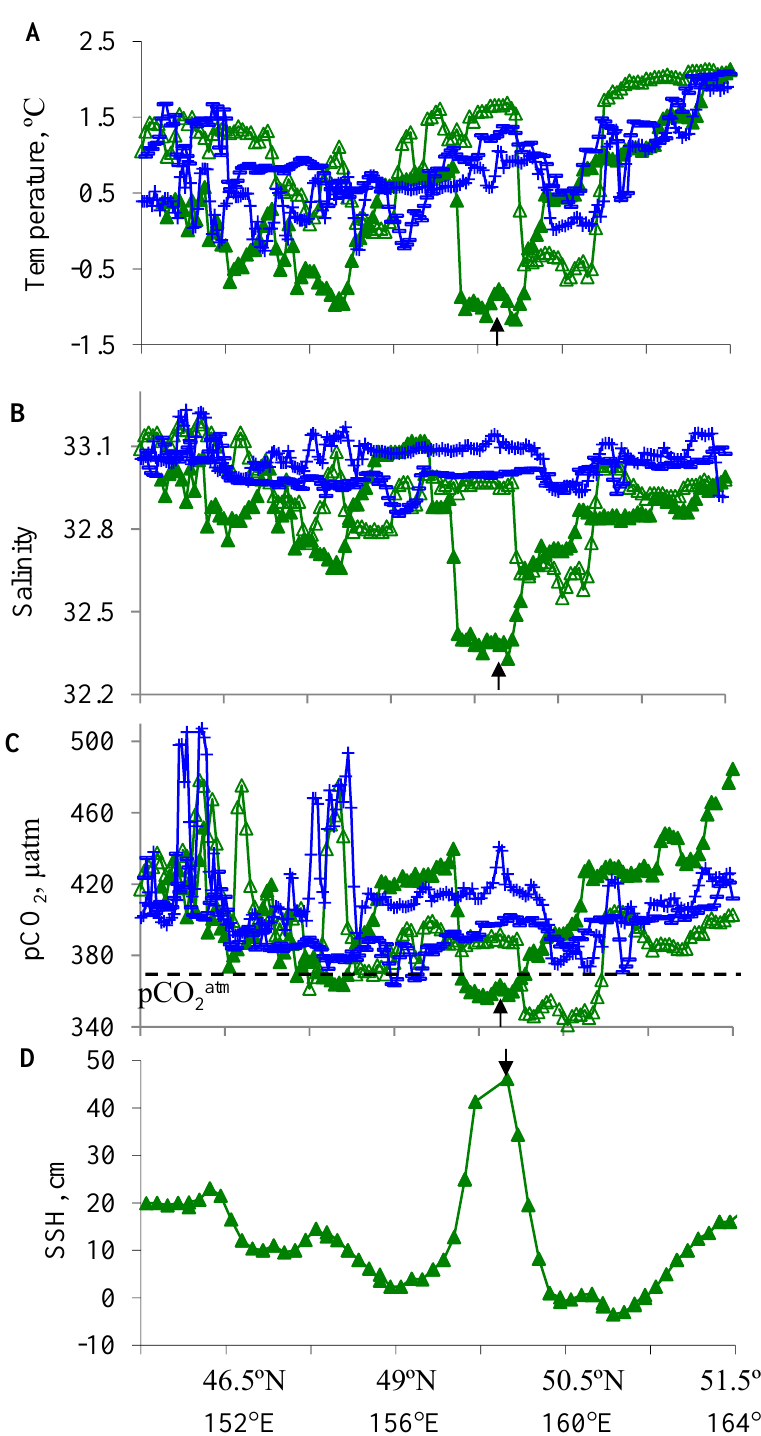
Figure 6. The distributions of the temperature ( A ), salinity ( B ), pCO 2 ( C ), and SSH ( D ) in the EKC zone in winter 1999 and winter 2000 (see Figure 2A). Unfilled green triangles—30.01.–01.02.1999, filled green triangles—14–16.03.1999, blue strokes—09–11.02.2000, blue pluses—15–16.03.2000. The arrows point to the center of the Kamchatka anticyclone eddy (14–16 March 1999).